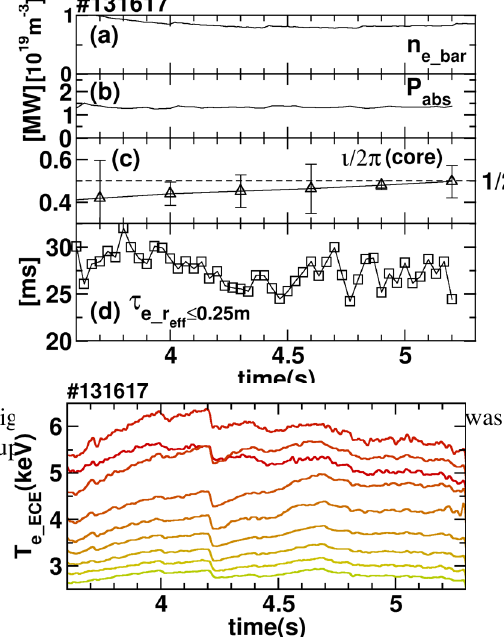
Fig.14 : Low pass filtered (f cutoff =40Hz) ECE measured at 0.07 m ≤ r eff ≤ 0.24 m in the same discharge of